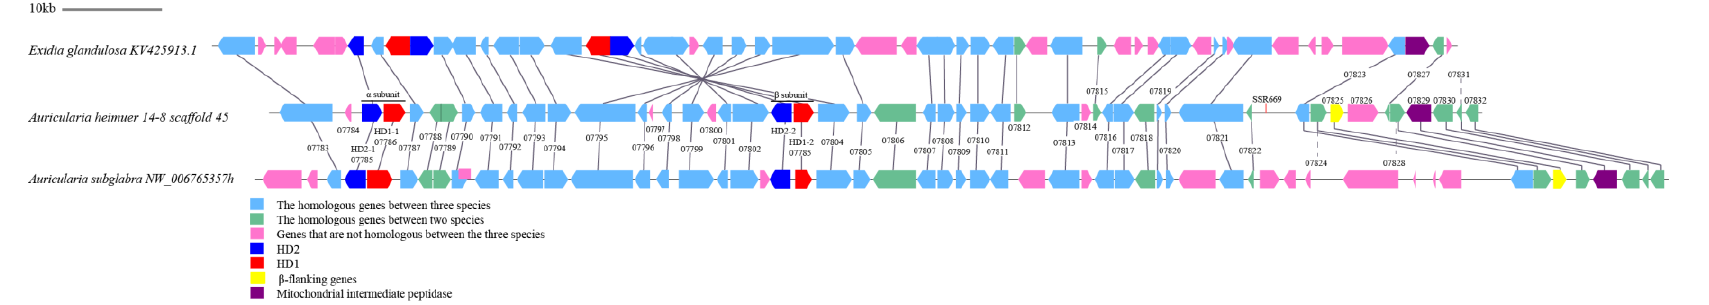
Figure 7. Synteny of genes on MAT-A of A. heimuer, A. subglabra, and E. glandulosa.